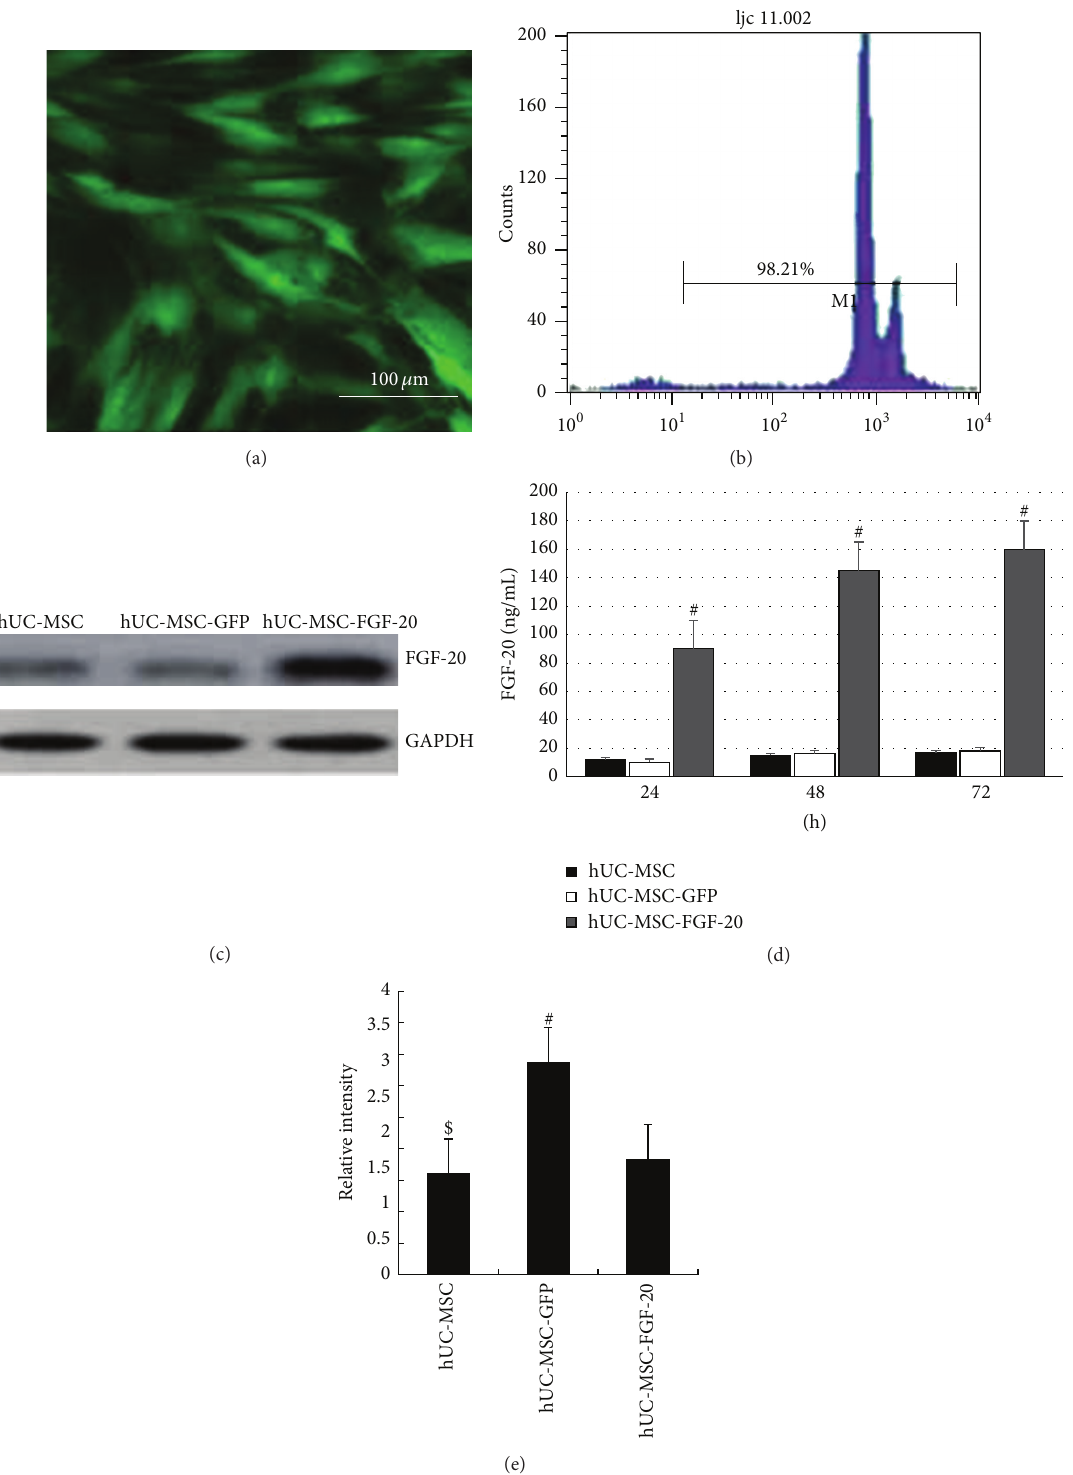
Figure 1: The expression of FGF-20 in transduced hUC-MSCs in vitro. (a) Expression of GFP in hUC-MSCs transduced by Ad-GFP as determined by fluorescence microscopy. (b) Flow cytometric analysis of GFP expression in UCMSC transduced by Ad-GFP. (c) Production of bioactive FGF-20 in the supernatant of hUC-MSCs. Supernatant from cultured cells was retrieved on the indicated time points, processed, and analyzed using a mouse specific FGF-20 ELISA assay. (d) Typical bands of FGF-20 and GAPDH detected by western blotting. (e) Gray intensity analysis of FGF-20. All data are presented as mean ± standard error of mean ( # 𝑝 < 0.01 , hUC-MSCs versus hUC-MSC-FGF-20 and UCMSC-GFP; $ 𝑝 < 0.01 , hUC-MSCs versus